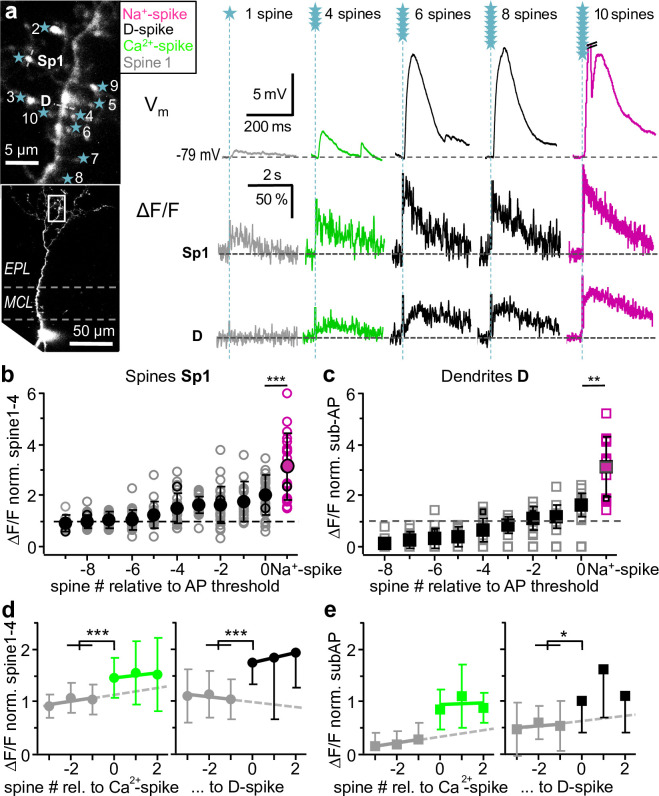
Additional ΔCa2+ in spine and dendrite caused by nonlocal spikes.a: Left: Scan of representative granule cell. Sp1 and D indicate line scan sites, stars indicate uncaging spots. Right: Somatic Vm recordings (top) and line scans in spine (Sp1) and dendritic location (D) for increasing spine numbers (bottom). Gray traces: below Ca2+-spike, green traces: at Ca2+-spike threshold; black traces: at and above D-spike threshold; magenta traces: suprathreshold for global Na+-AP. Na+-AP truncated for clarity. b: Spine Ca2+ signals ΔF/F normalized to Sp1-4 (see Materials and methods) and aligned to Na+-AP threshold (n = 33 spines in 16 GCs); Gray circles ○: individual spines, solid black ●: mean; open black ○: spine from a, open magenta ○: AP data from individual spines; solid magenta with black outline ●: mean global Na+-spike data (responses with more than 1 AP were not taken into account). Gradual increase from −6 spines onwards of spine ΔF/F with highly significant additional increase upon AP generation (n = 20 pairs, Wilcoxon, p < 0.001). c: Dendritic Ca2+ signals ΔF/F normalized to mean above Ca2+-spike threshold and below global Na+-spike threshold (see Materials and methods; n = 19 cells). Symbols as in right panel, with squares instead of circles. Gradual increase from −5 spines onwards with significant additional increase upon global Na+-spike generation (n = 12 pairs, Wilcoxon, p = 0.001). d: Spine ΔF/F normalized as in b, arranged relative to Ca2+-spike threshold (left panel, n = 26 in 14 cells, Wilcoxon test, p < 0.001, see Materials and methods) and relative to D-spike threshold (right panel, n = 19 in 10 cells, p < 0.001). See S2A and S2B Fig for individual data points. Gray symbols: subthreshold Ca2+-spike/D-spike, green symbols: suprathreshold Ca2+-spike, black symbols: suprathreshold D-spike, dashed line: linear fit of subthreshold mean amplitudes, also for e. e: Dendrite ΔF/F normalized as in c, arranged relative to Ca2+-spike threshold (left panel, n = 17, significance not tested, because increase in dendritic ΔF/F above noise level was criterion for onset of Ca2+-spike) and relative to D-spike threshold (right panel, n = 12, Wilcoxon, p = 0.015, see S2B Fig for individual data points). Symbols as in d, with squares instead of circles. AP, action potential; D-spike, dendritic Na+-spike.